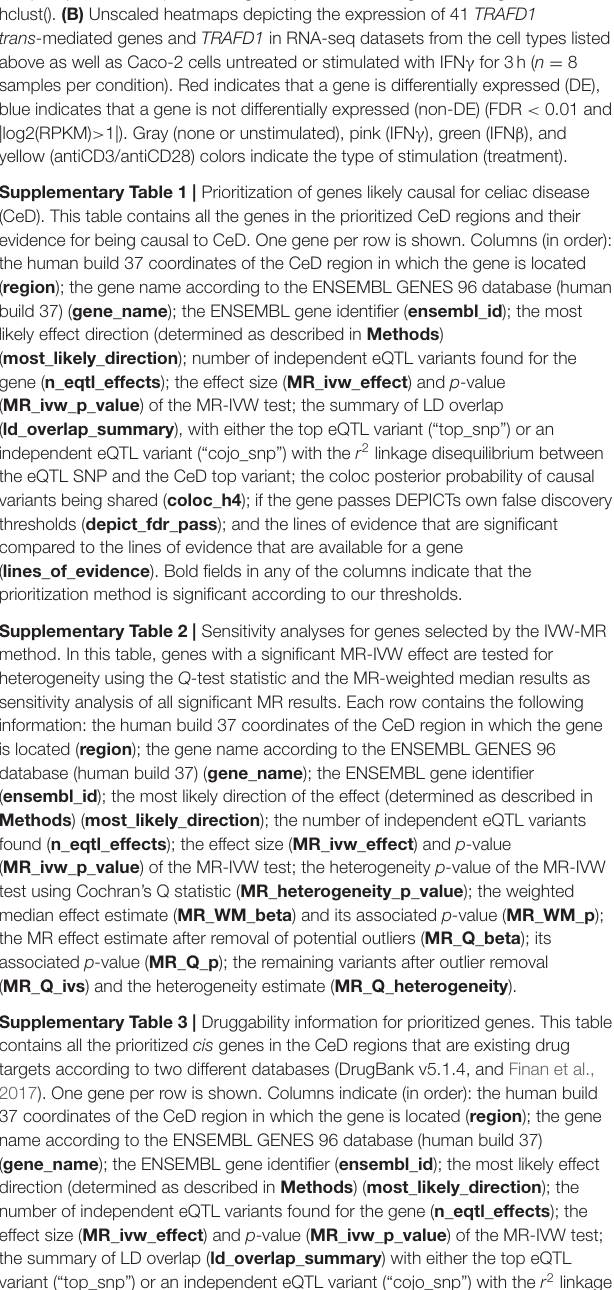
Supplementary Table 2 | Sensitivity analyses for genes selected by the IVW-MR method. In this table, genes with a significant MR-IVW effect are tested for heterogeneity using the Q -test statistic and the MR-weighted median results as sensitivity analysis of all significant MR results. Each row contains the following information: the human build 37 coordinates of the CeD region in which the gene is located ( region ); the gene name according to the ENSEMBL GENES